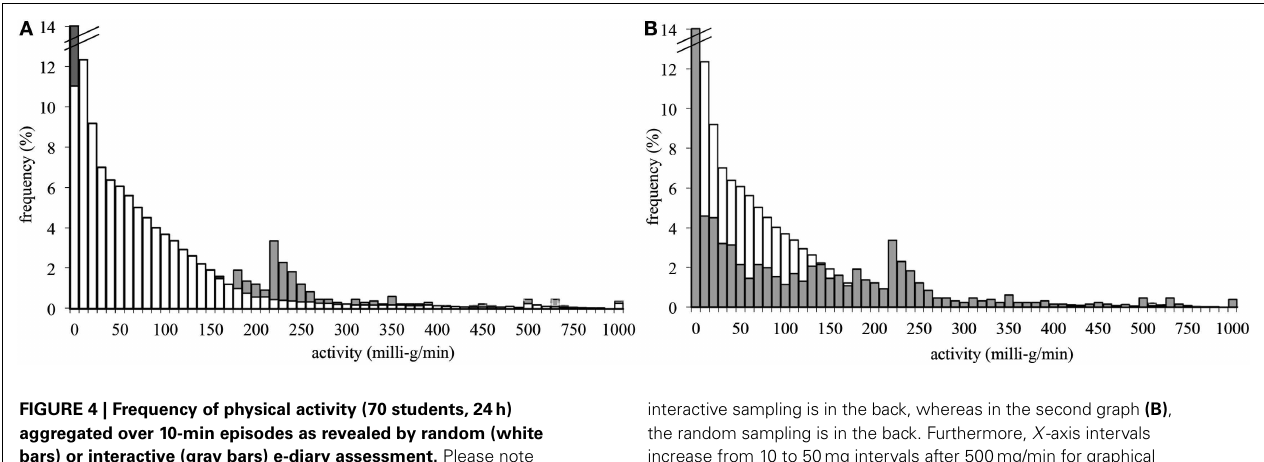
FIGURE 4 | Frequency of physical activity (70 students, 24h) aggregated over 10-min episodes as revealed by random (white bars) or interactive (gray bars) e-diary assessment. Please note that both graphs show the same data. In the first graph (A) , the